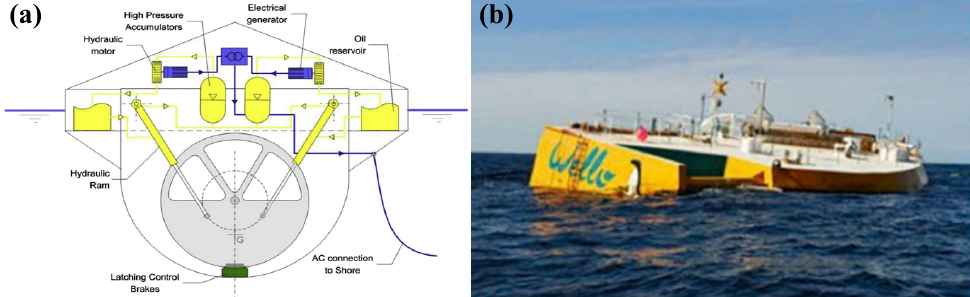
Figure 8. The SEAREV device [114] and the Wello Penguin device [115] are shown as typical examples of self-contained two-body PAs in ( a , b ),